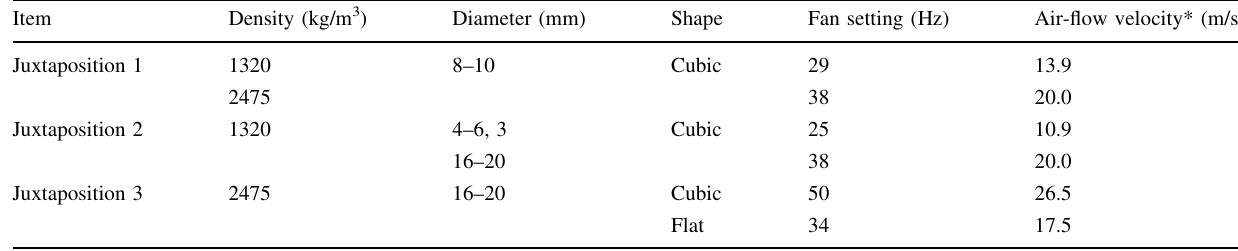
*Calculated according to the trend line (Fig.